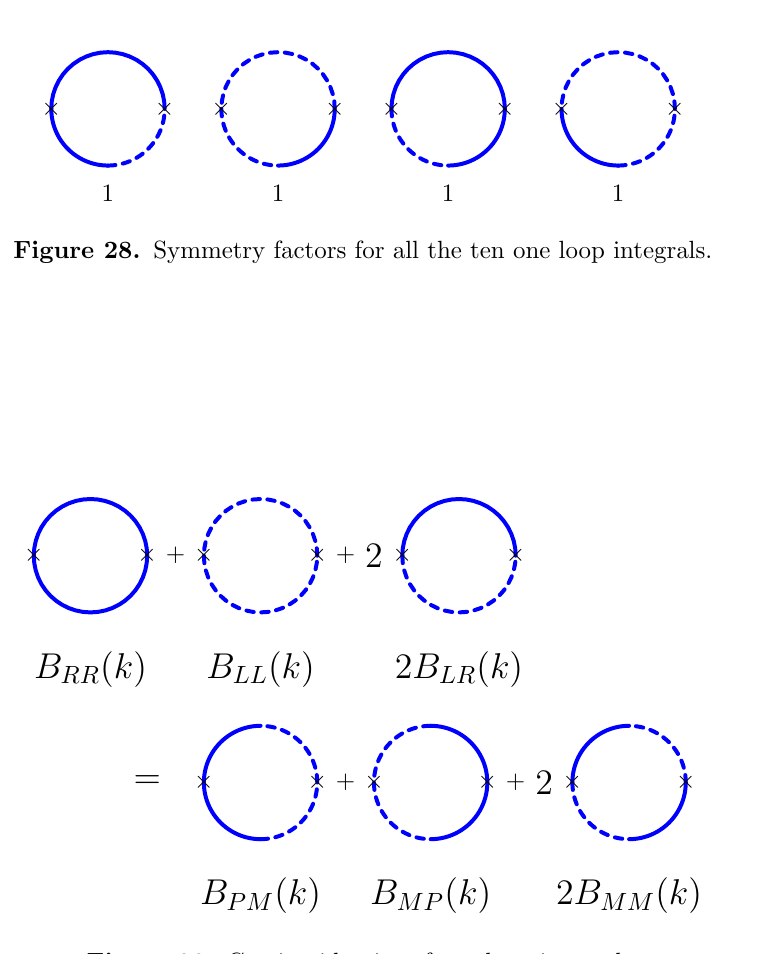
Figure 29. Cutting identity of one loop